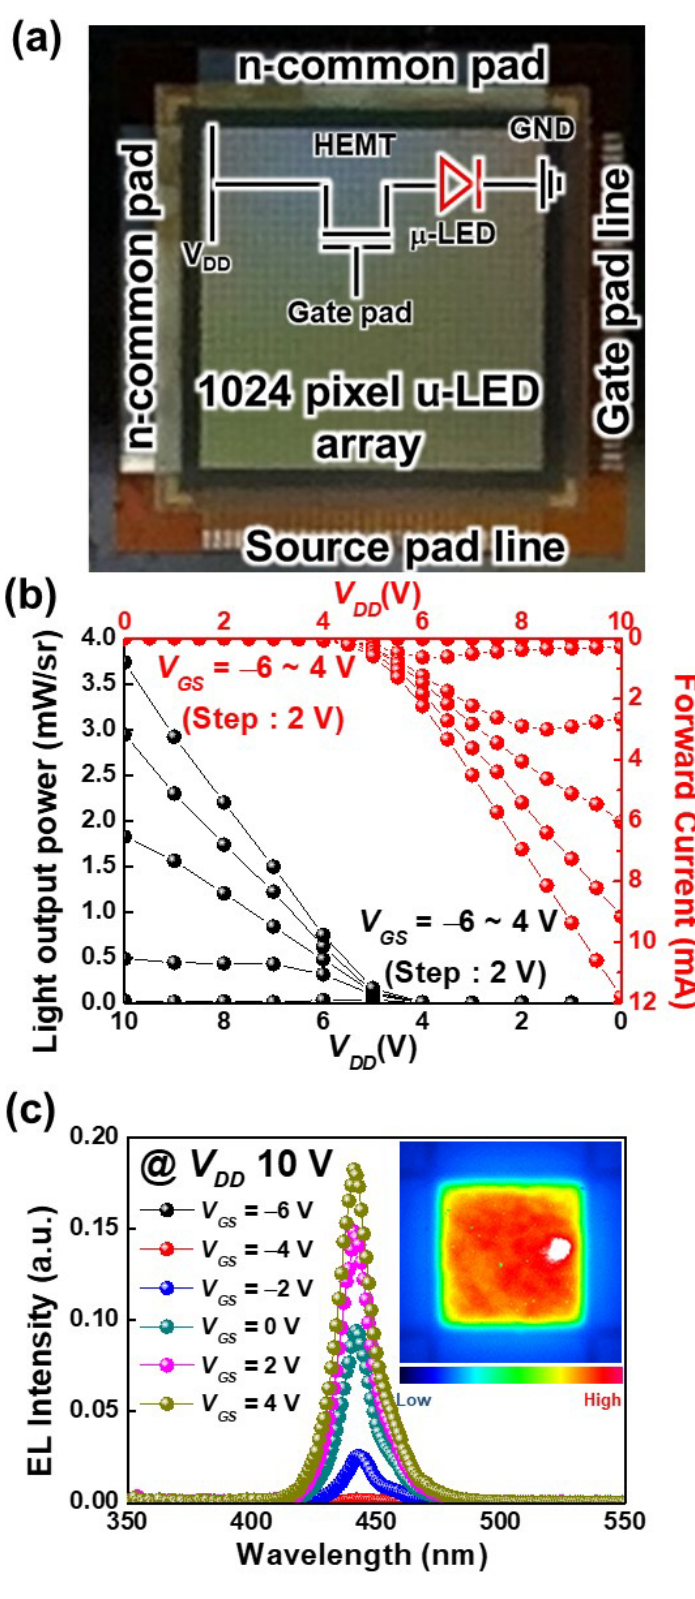
Figure 6. ( a ) Optical microscope image of the 32 × 32 pixelated µ -LED-on-HEMT arrays. ( b ) LOP and forward current characteristics of the µ -LED-on-HEMT arrays at different V GS . ( c ) EL spectra of fabricated µ -LED-on-HEMT arrays at different V GS . The inset shows the light intensity distribution at V GS = 4 V. Both the LOP and forward voltage increased with an increase in V GS . At V DD = 10 V, the LOP and the forward voltage increased from 0 to 3.7 mW and 0 to 11.8 mA, respectively, as the V GS increased from − 6 to 4 V. At V GS = − 6 V, there was no LOP from the integrated μ-LED arrays with HEMT arrays. The V th of the HEMT arrays was about − 4.6 V (see Figure 4); there- fore, the integrated μ-LED devices could be operated at only ≥− 4.5 V. In order to turn on the